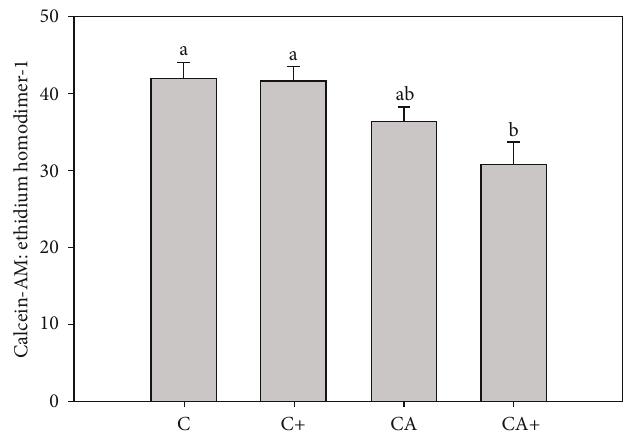
Figure 2: Ratio of calcein-AM to ethidium homodimer-1 in cartilage explants (C) in the presence or absence of adipose tissue explants (A) and/or LPS (+). Data represent duplicate samples from 16 market-weight pigs. Di ff erent letters denote signi fi cantly di ff erent means ( p < 0 : 05 ).